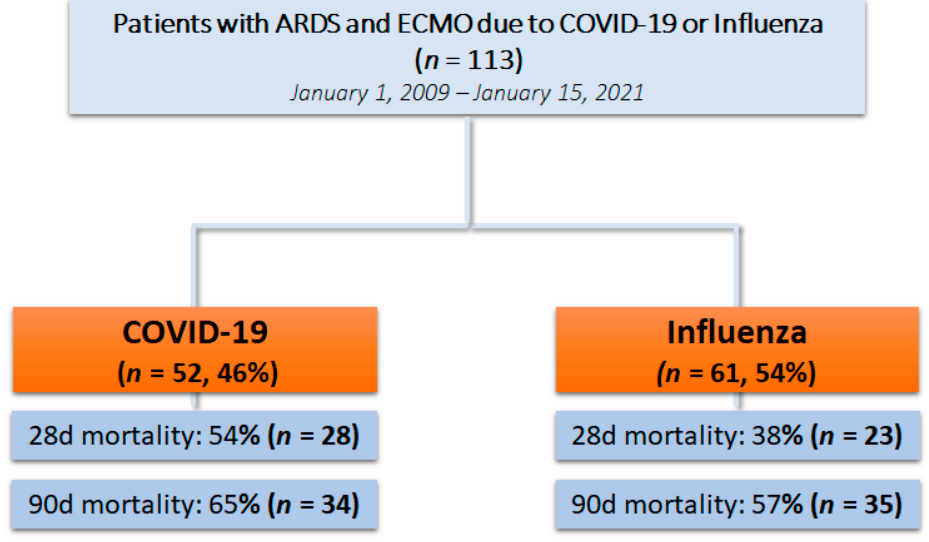
Figure 1. Study flow chart.